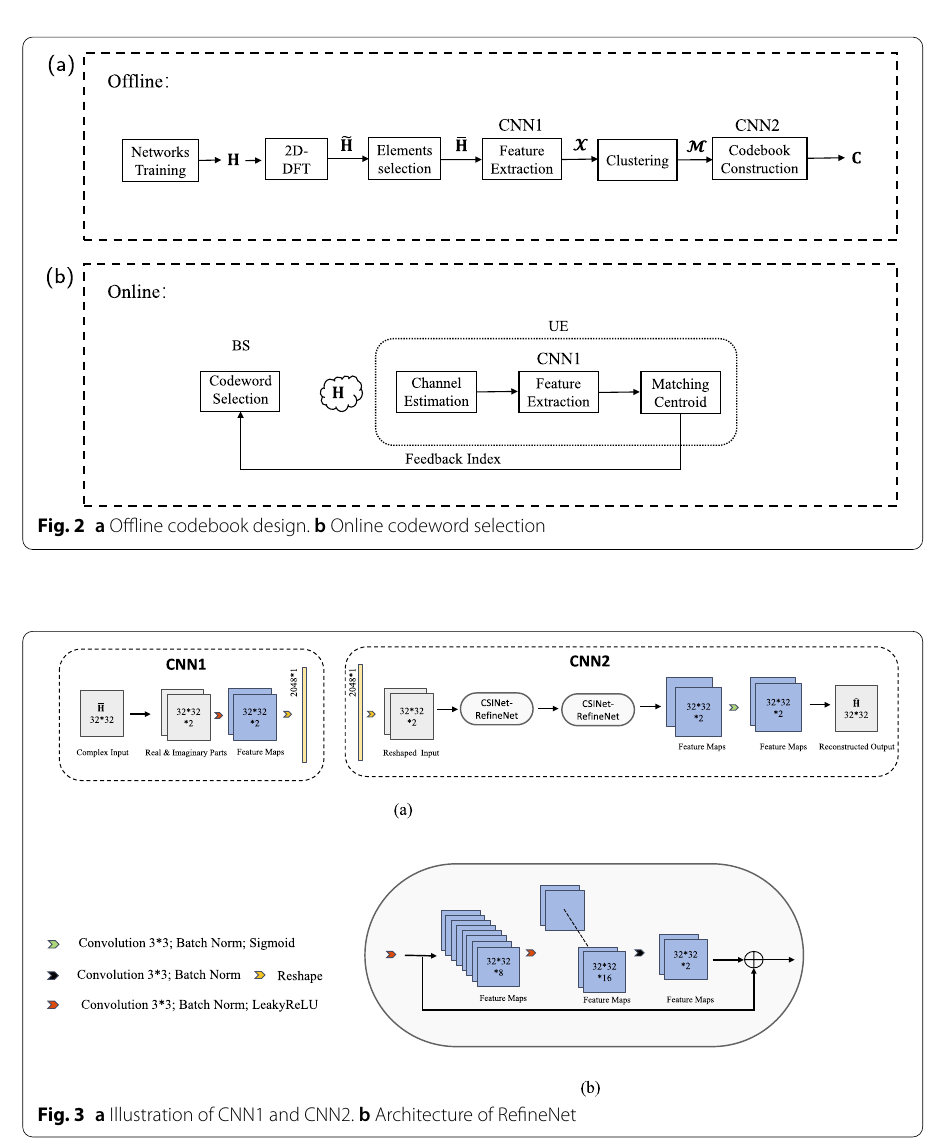
Fig. 3 a Illustration of CNN1 and CNN2. b Architecture of